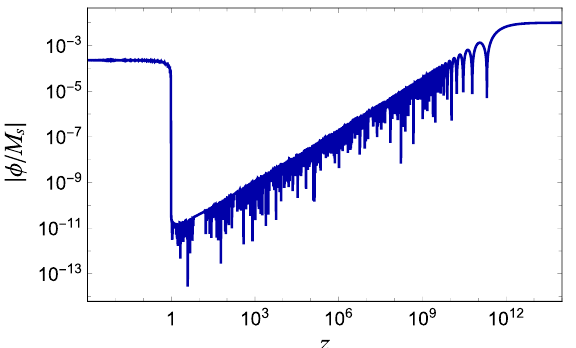
Figure 1. Cosmological evolution of the symmetron field as a function of redshift in a universe field with radiation ( w γ = 1/3, Ω γ ∼ 10 − 4 ), pressureless matter ( w m = 0, Ω m = 0.25) and a cosmological constant ( w Λ = − 1, Ω Λ ≈ 1 − Ω m ), for the quadratic variant of the symmetron model, √ / M 2 s . For this choice of parameters, the with M s = 10 − 4 M Pl , µ = 15 H 0 M Pl / M s , and λ = µ 2 M 2 Pl phase transition occurs at z ≈